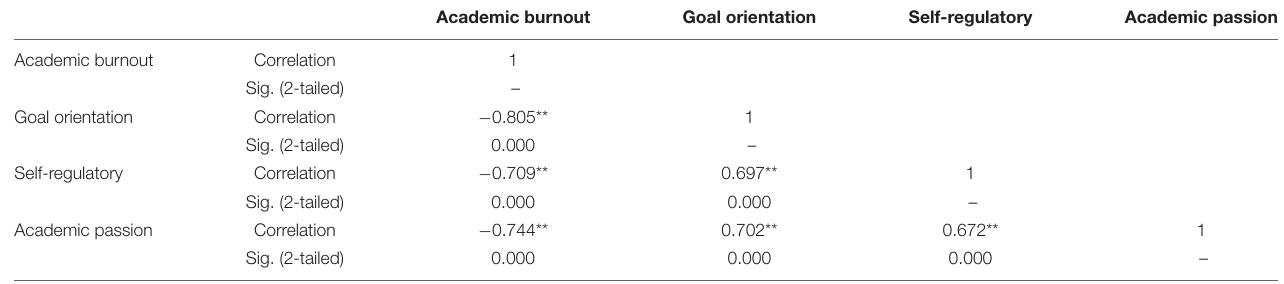
TABLE 4 | Correlation between research variables.